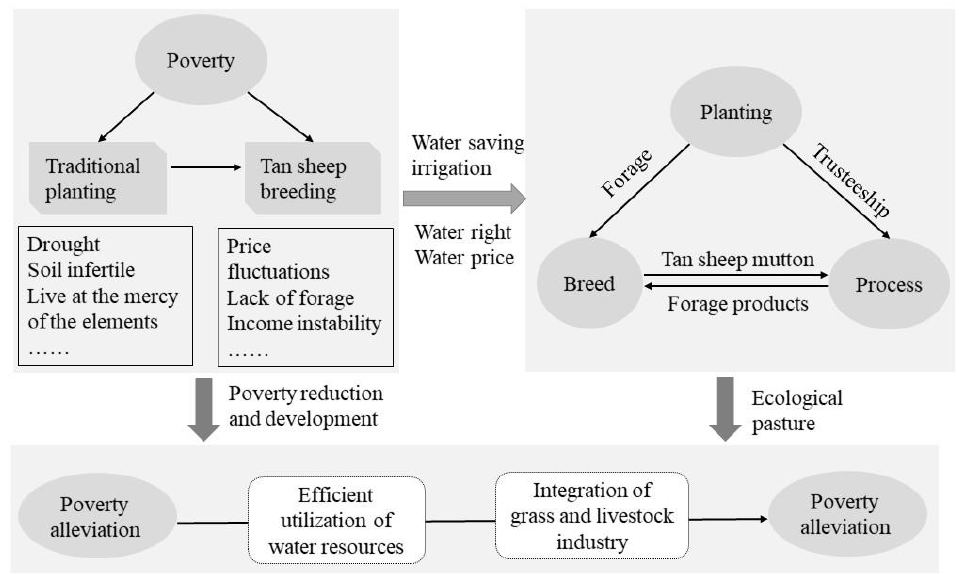
Figure 6. Efficient utilization of water resources and integrated development mode in Ma’erzhuang.